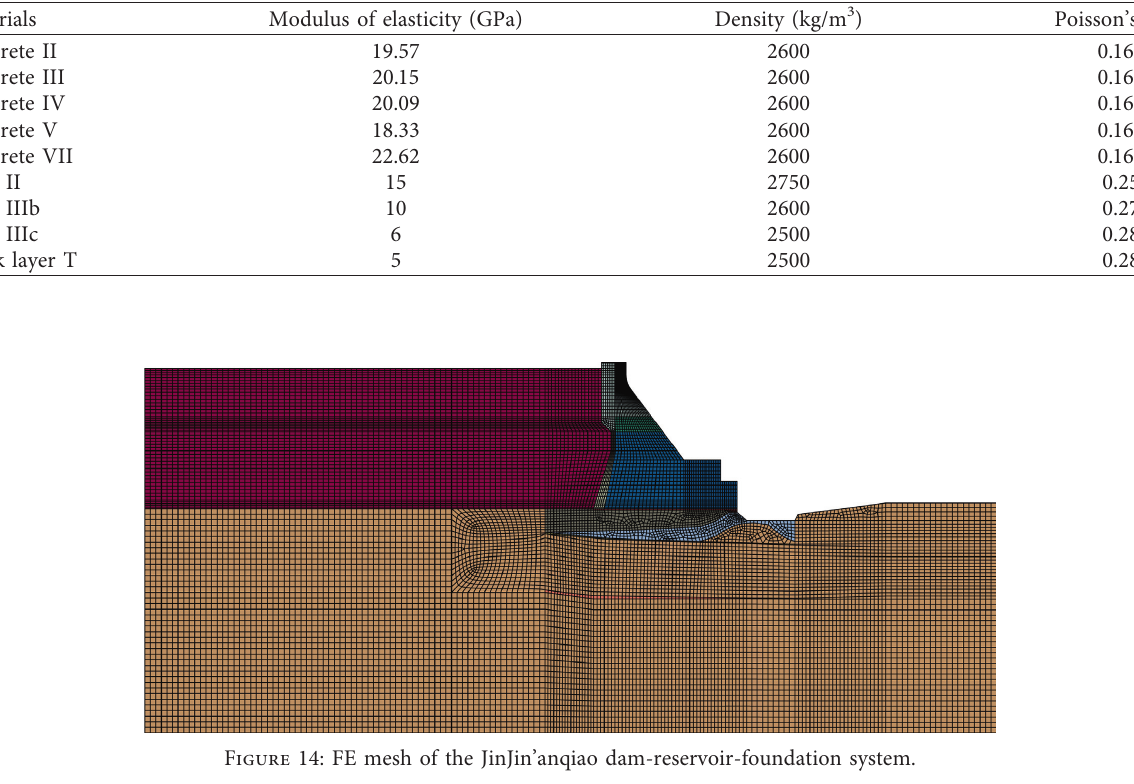
Table 2: The mechanical properties of concrete and rock